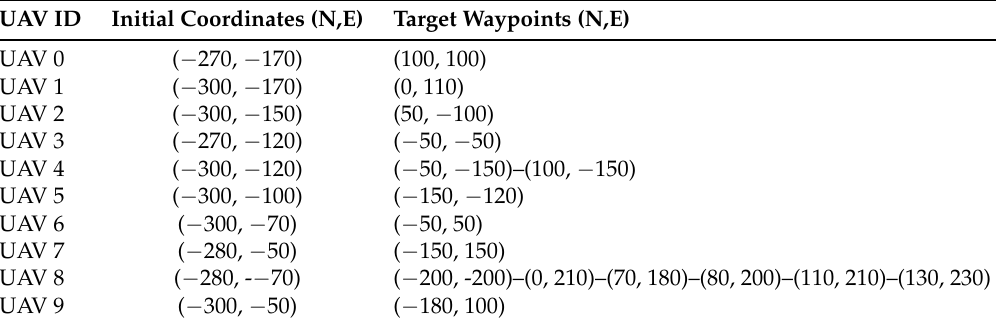
Table 4. Simulation of collision avoidance of MUAVS: Case 2.